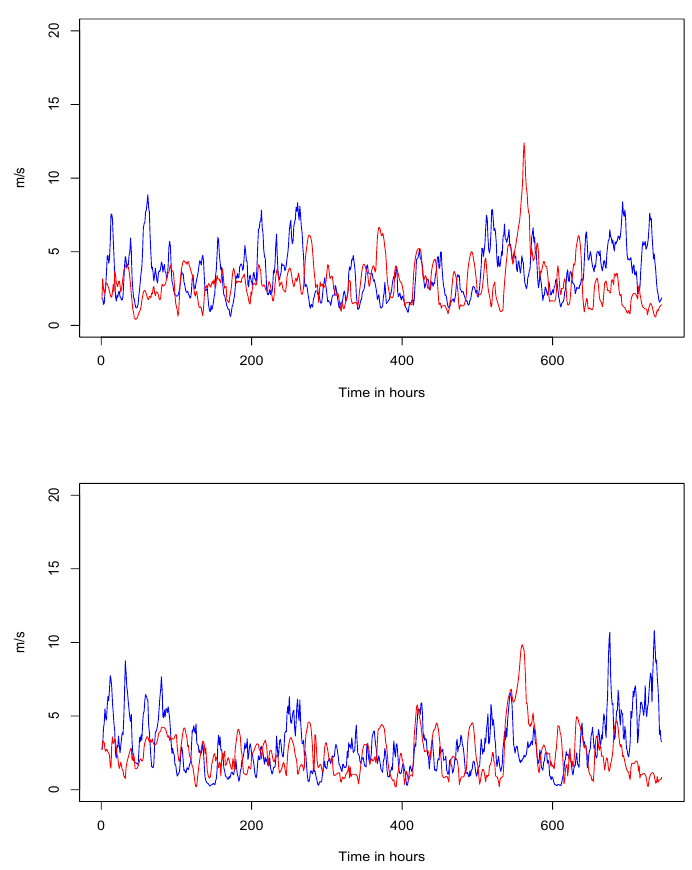
Figure 10. Overhead, hourly Nantes wind speed (red line) vs. simulation path (blue line), followed by hourly Paris wind speed (red line) vs. simulation path (blue line) for the period 1 January–1 February